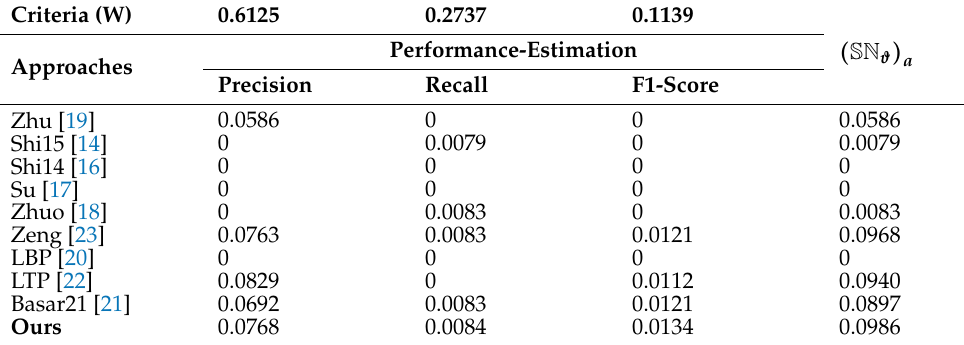
Table 9. Analysis outputs of the calculated aggregate ( N ϑ )